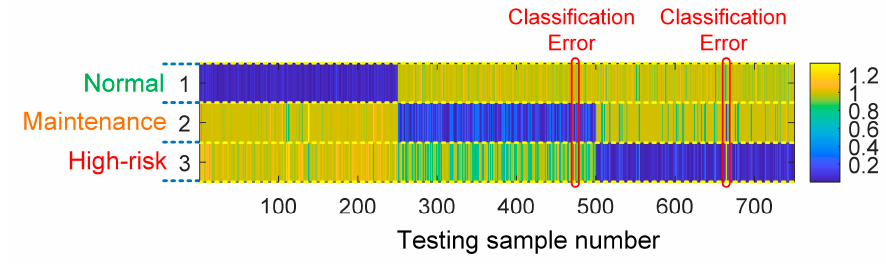
Figure 15. LGPG: reconstruction error matrix.